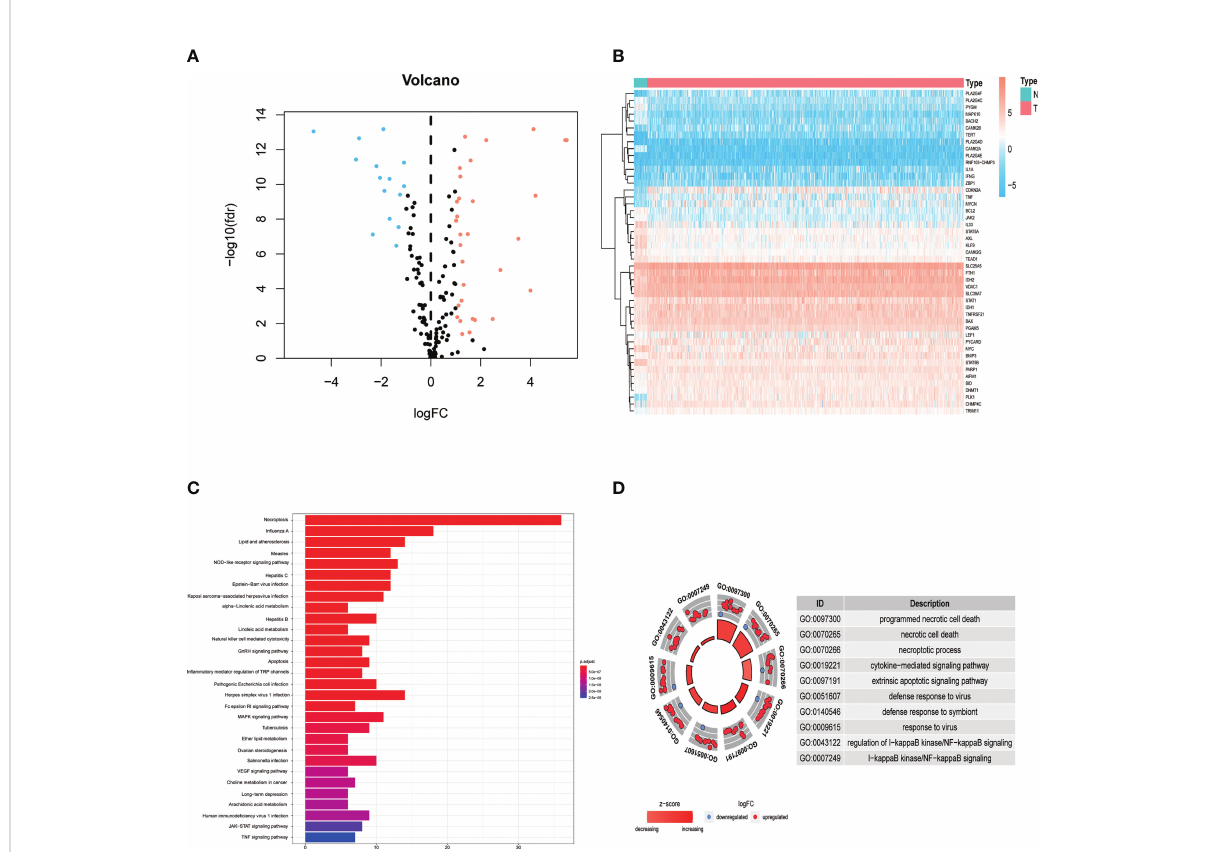
FIGURE 2 Identi fi cation and functional annotation of necroptosis-related differentially expressed genes (DEGs) in patients with EC. (A) The volcano plot of 47 necroptosis-related DEGs in EC, blue dots represent downregulated genes and orange dots represent upregulated genes. (B) The heatmap shows the expression of necroptosis-related DEGs between normal and cancer tissues. (C) KEGG enrichment analysis of necroptosis-related DEGs. (D) GO enrichment analysis of necroptosis-related